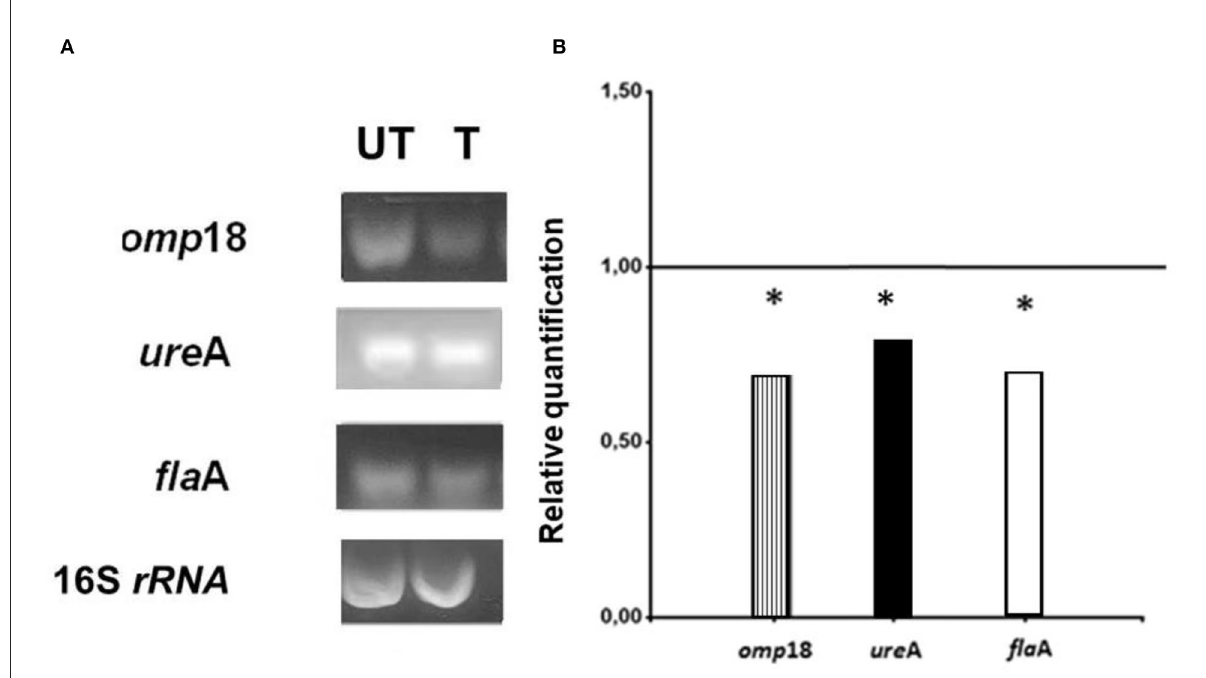
FIGURE3 (A) Electrophoretic gels: Helicobacter pylori amplicons resulting from RT-PCR in 1.8 % agarose gels stained with Gel Red ® . (T) Treated cultures and (UT) Untreated cultures of H. pylori with asclepain cI. (B) Relative quantification of the H. pylori virulence gene expression, before and after treating H. pylori cultures with asclepain cI. The relative quantification represents the mean ± SD of three independent experiments. * p ≤ 0.05 according to the Student’s t